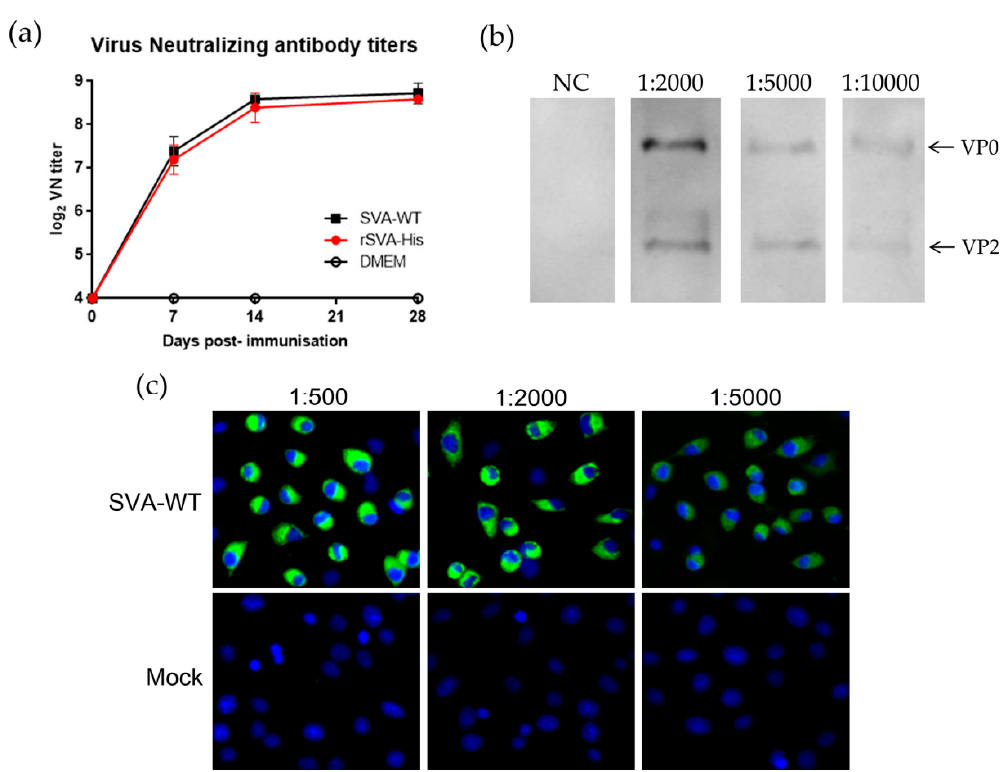
Figure 6. Antibody response of rabbits inoculated with purified rSVA ‐ His. Nine rabbits were randomly divided into three groups (n = 3/group) and intramuscular injection twice with 10 μ g purified parental SVA and purified rSVA ‐ His. DMEM was inoculated as a negative control. Blood samples were collected on day 0 pre ‐ vaccination and 1, 2, and 4 weeks post ‐ vaccination. ( a ) Titers of neutralizing antibodies were detected by virus neutralization test and are expressed as a log2 value. ( b ) WB analysis of SVA ‐ WT ‐ infected BHK ‐ 21 cells with immunized rabbit serum. The rabbit serum was diluted 2000, 5000, and 10,000 times. Normal cell lysates were used as the control. ( c ) IFA of SVA ‐ WT ‐ infected cells with immunized rabbit serum. SVA ‐ WT ‐ infected BHK ‐ 21 cells were incubated with several dilutions (1:500, 1:2000, and 1:5000) of the rabbit serum. Normal BHK ‐ 21 cells were used as the control.